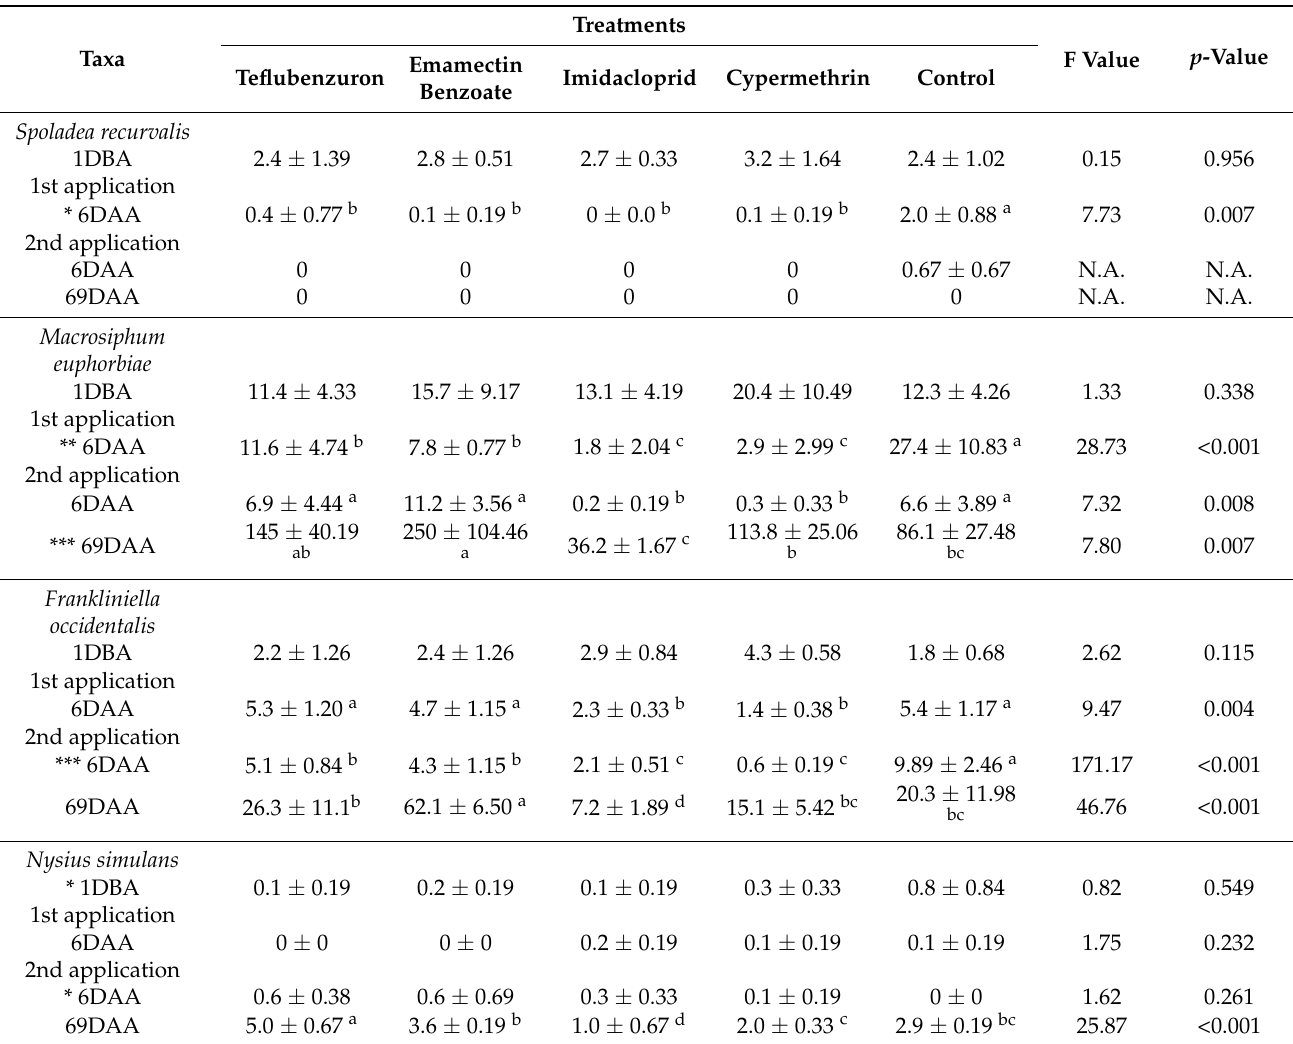
F Value p -Value